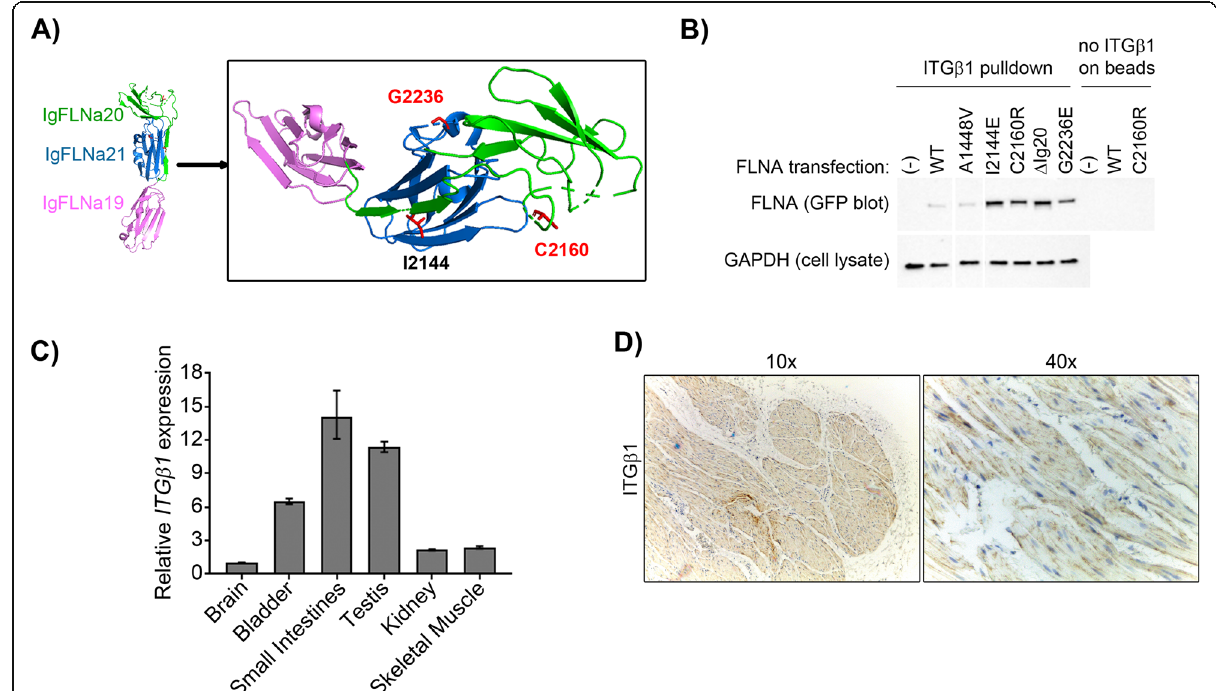
Fig. 4 PBS FLNA mutations disrupt binding to integrin. a PyMol 3D protein standard cartoon of wildtype IgFLNA repeats 19 (magenta), 20 (green), and 21 (blue) showing the auto-inhibitory IgFLNA20 β -strand A on the β -strand C/D face of IgFLNA21. Shown in red are C2160 and G2236, the locations of the two FLNA residues in Ig20 and Ig21 mutated in PBS (PDB code 2J3S). The position of the IgFLNA20 β -strand A residue I2144 is shown in black; although it has not been reported mutated in humans, the I2144E mutation has been shown to lead to increased FLNA- ITG β binding. The FLNA PBS mutation p.A1448V in Ig13 is not shown. b Pulldown assay showing that p.C2160R and p.G2236E mutations enhance binding to ITG β 1 similarly to engineered positive controls p.I2144E and p. Δ Ig20. In contrast, p.A1448V binds ITG β 1 similar to WT. CHO cells were transfected with full length FLNA and bound to ITG β 1 tails on beads. c qPCR across adult human tissues shows ITGB1 expression is highest in small intestines but also strong bladder expression. ITGB1 expression normalized to GAPDH and relative to brain. d IHC from pediatric normal human bladder shows plasma membrane smooth muscle expression of ITG β